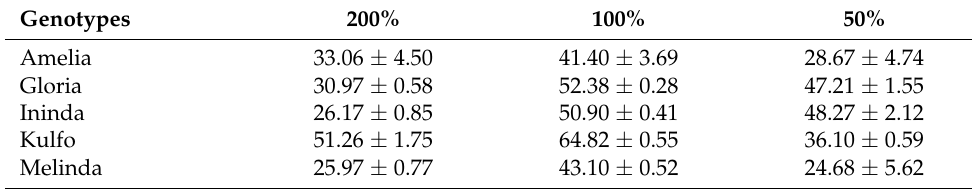
Table 4. Antioxidant properties of sweet potato flesh extracts at different concentrations.